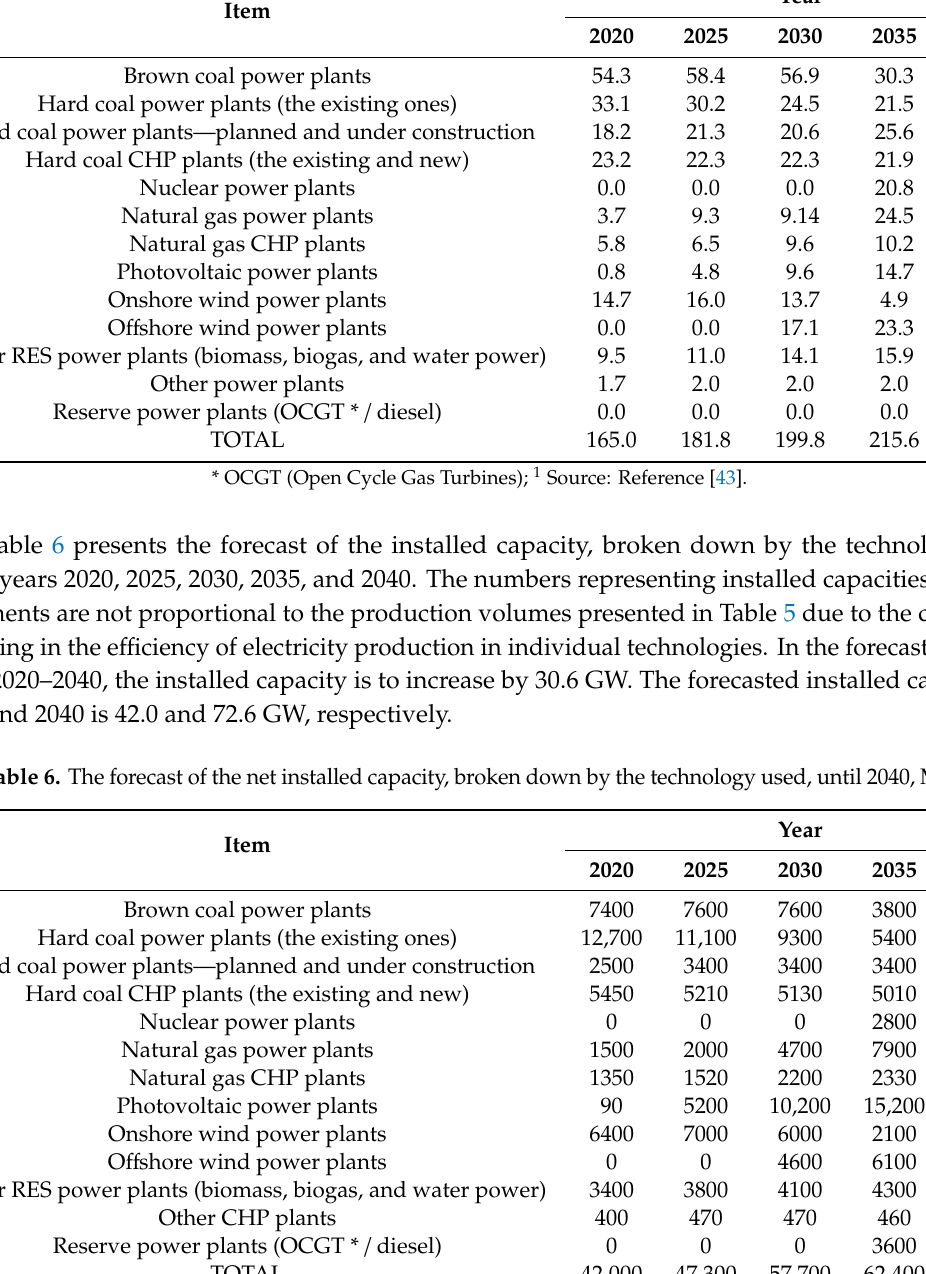
Table 5. Electricity production forecast for the year 2040 broken down by technology, TWh 1 . Item